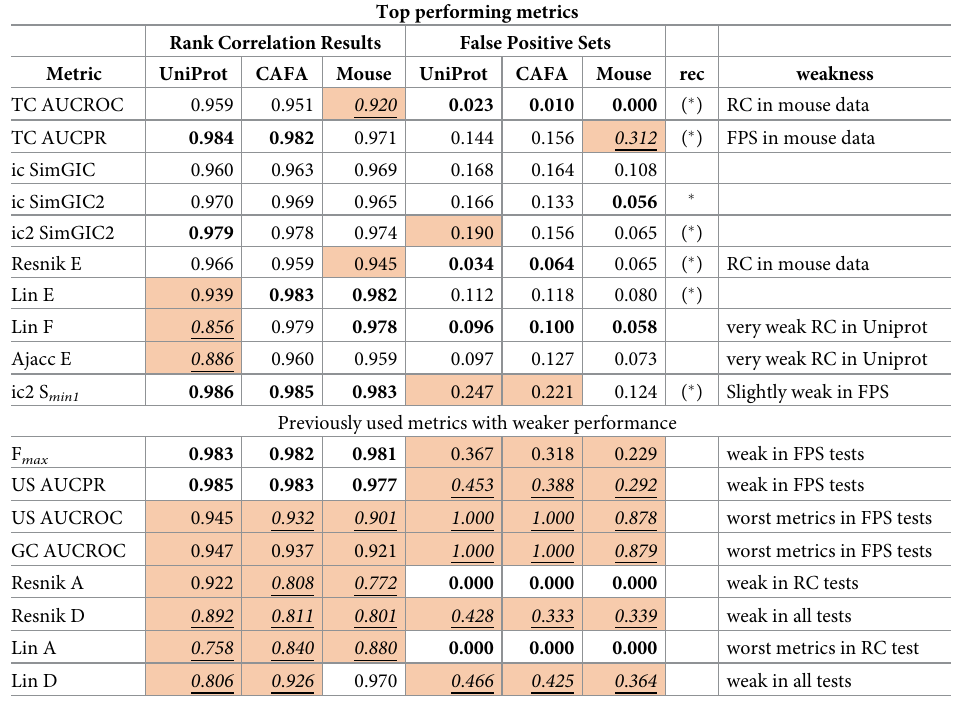
Table 1. Summary of results for best performing and widely-used metrics. Here we show RC (Rank Correlation) and FP (False Positive) results for the best performing methods. We also show same results for some widely-used met- rics. Good metrics should have a high RC score and low FP scores. Rec column shows our selected recommendations (See text for details). The five best results in each column are shown in bold. The five weakest results in each column are shown with underlined italics. Metrics that fail a given test are highlighted in red (see text for details). Note how methods in lower block show consistent weak performance either in RC or FP